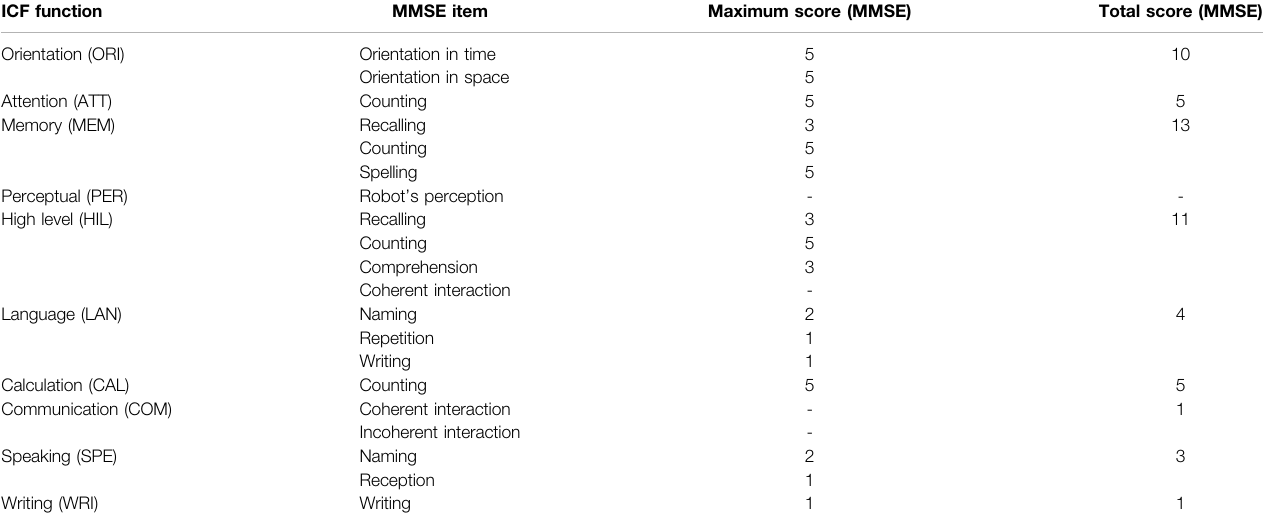
TABLE 1 | Mapping MMSE pro fi ling to ICF pro fi